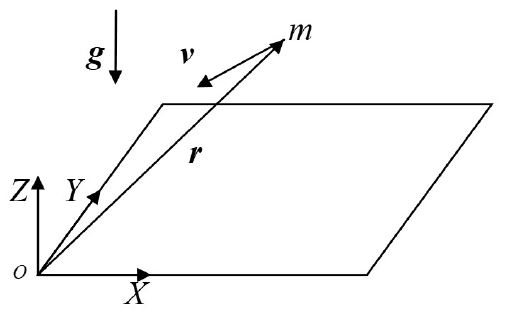
Figure 1. Navigation coordinates of planetary surface.